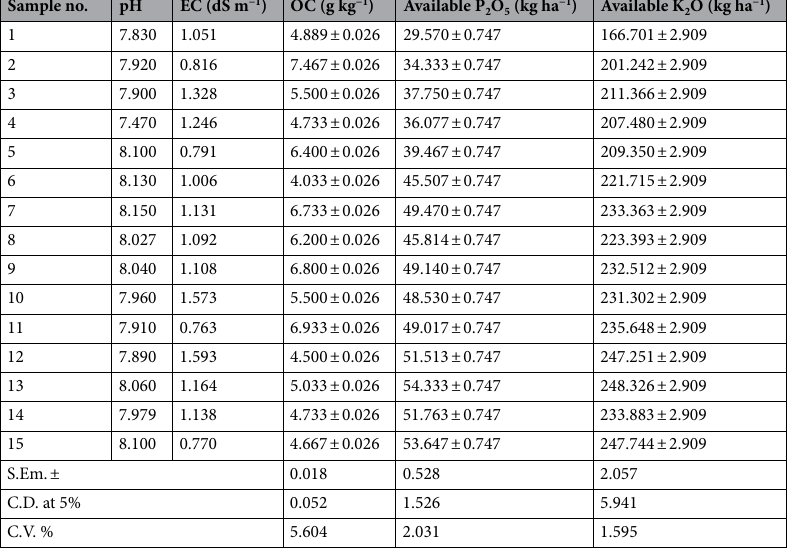
Table 1. Physico-chemical characteristics of soil samples. OC organic carbon; Values of OC, P 2 O 5 and K 2 O are mean ± standard error of three